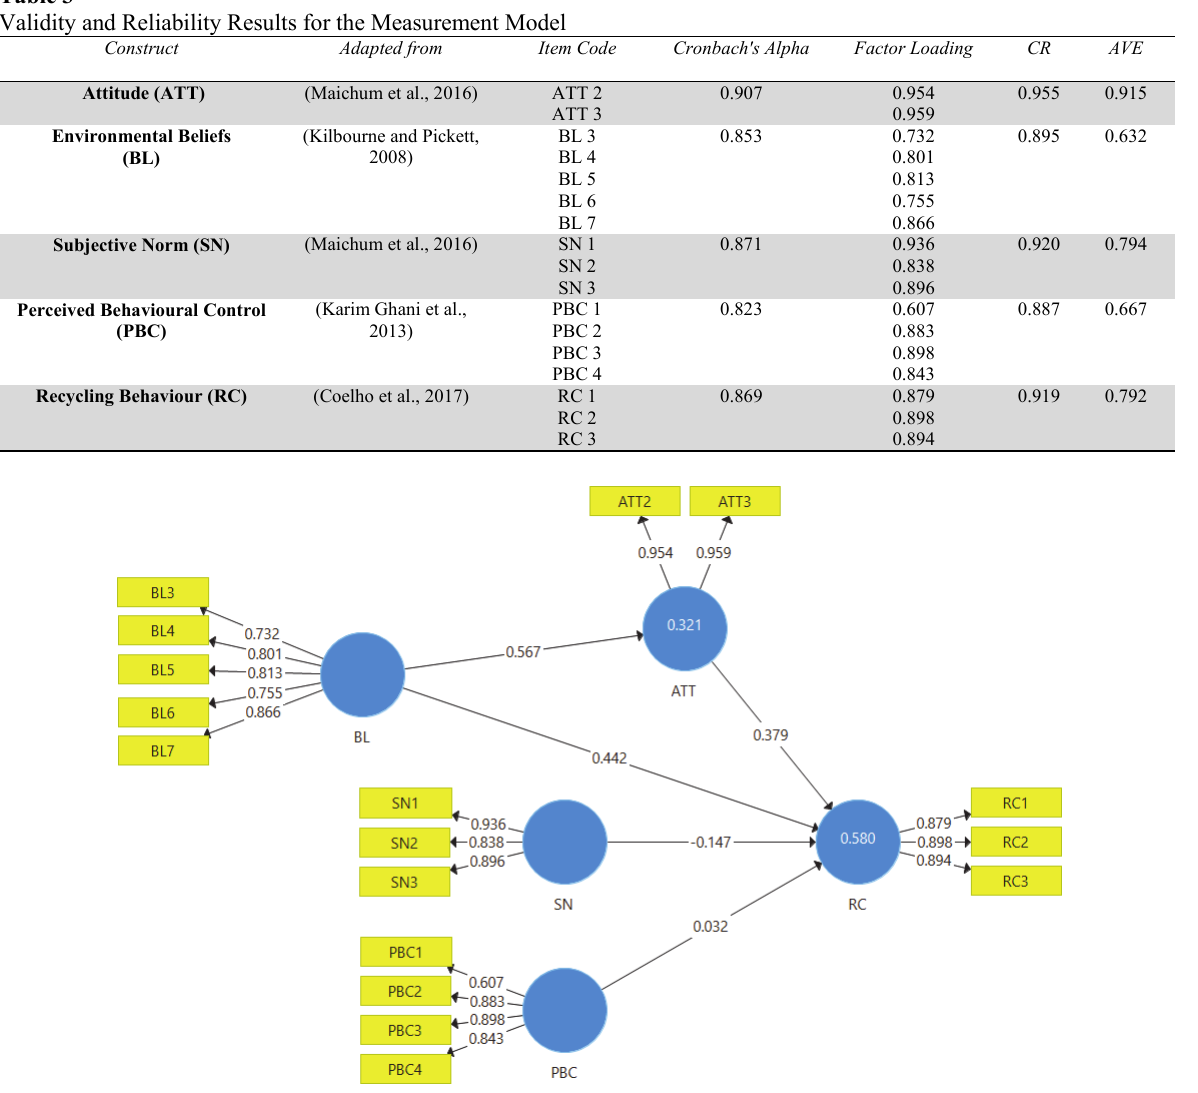
Fig. 3. Path analysis results for measurement